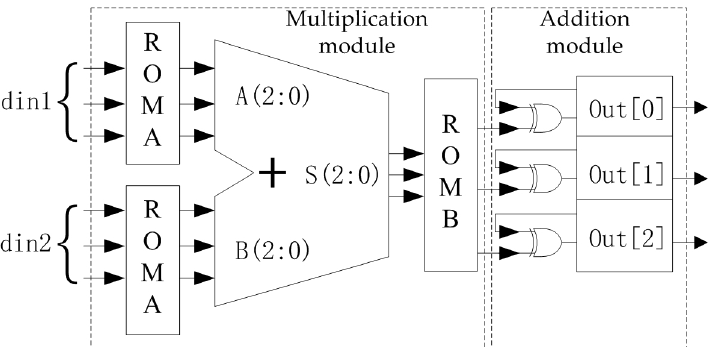
Figure 10. 8-ary LDPC code coding unit.